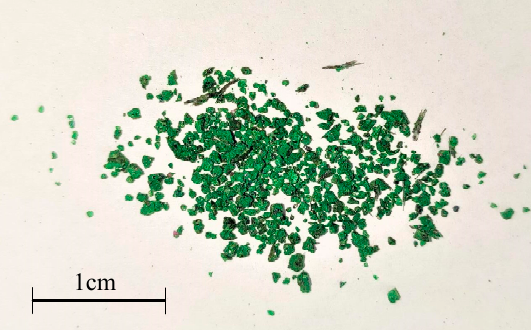
Figure 4. Nonferrous particle contaminants.